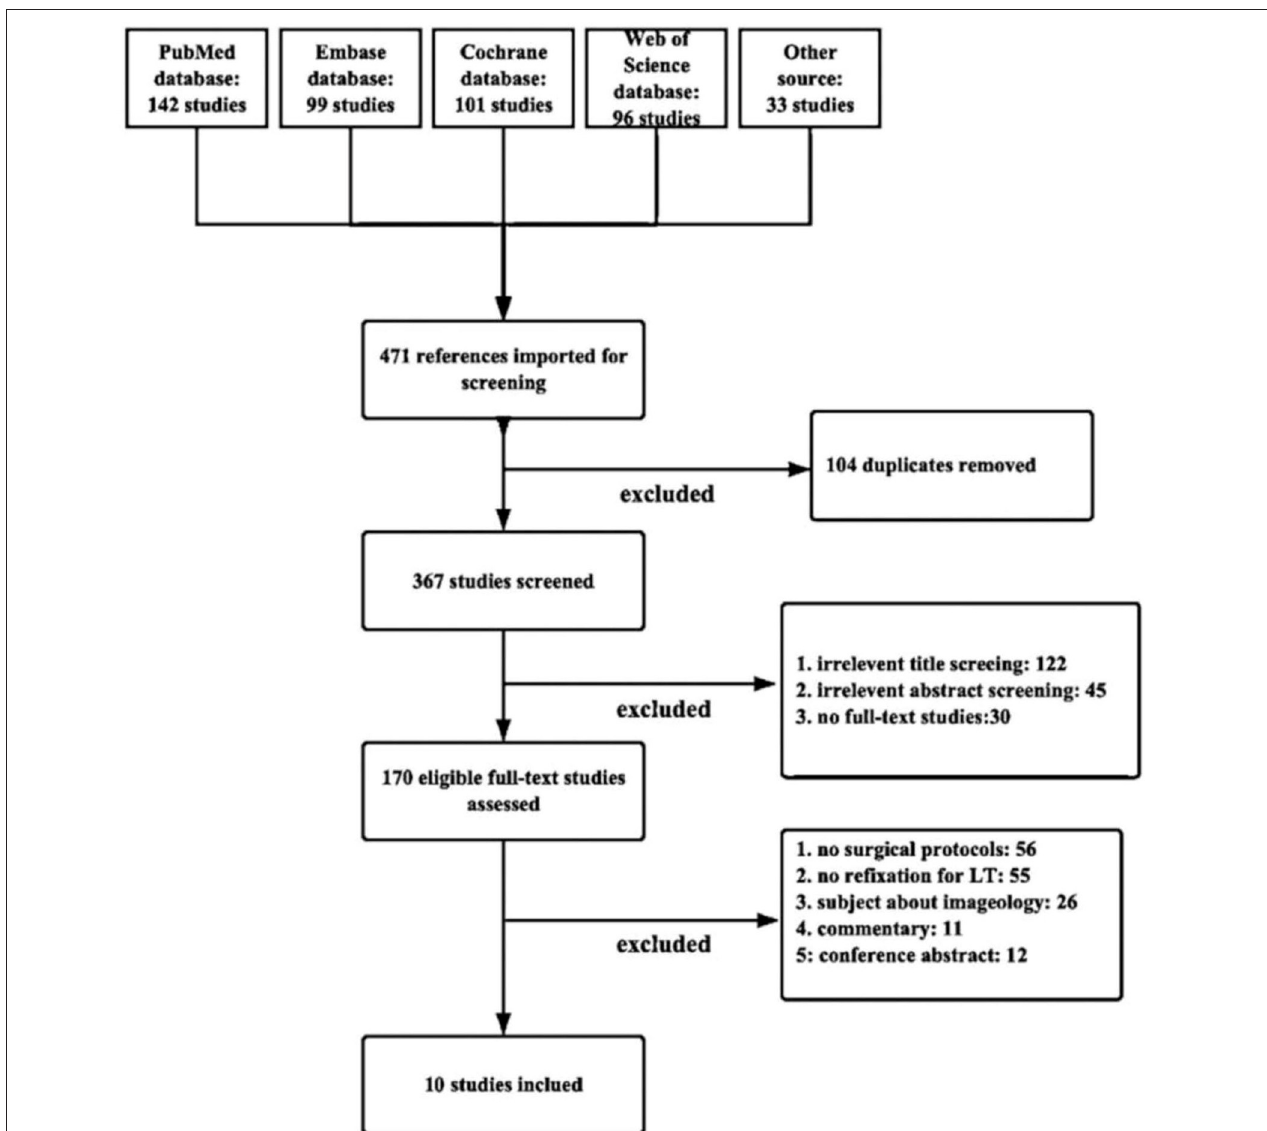
FIGURE 3 | PRISMA (Preferred Reporting Items for Systematic Meta-Analyses) flow diagram demonstrating the systematic review of the literature for studies investigating fixation necessity of displaced lesser trochanter in trochanteric